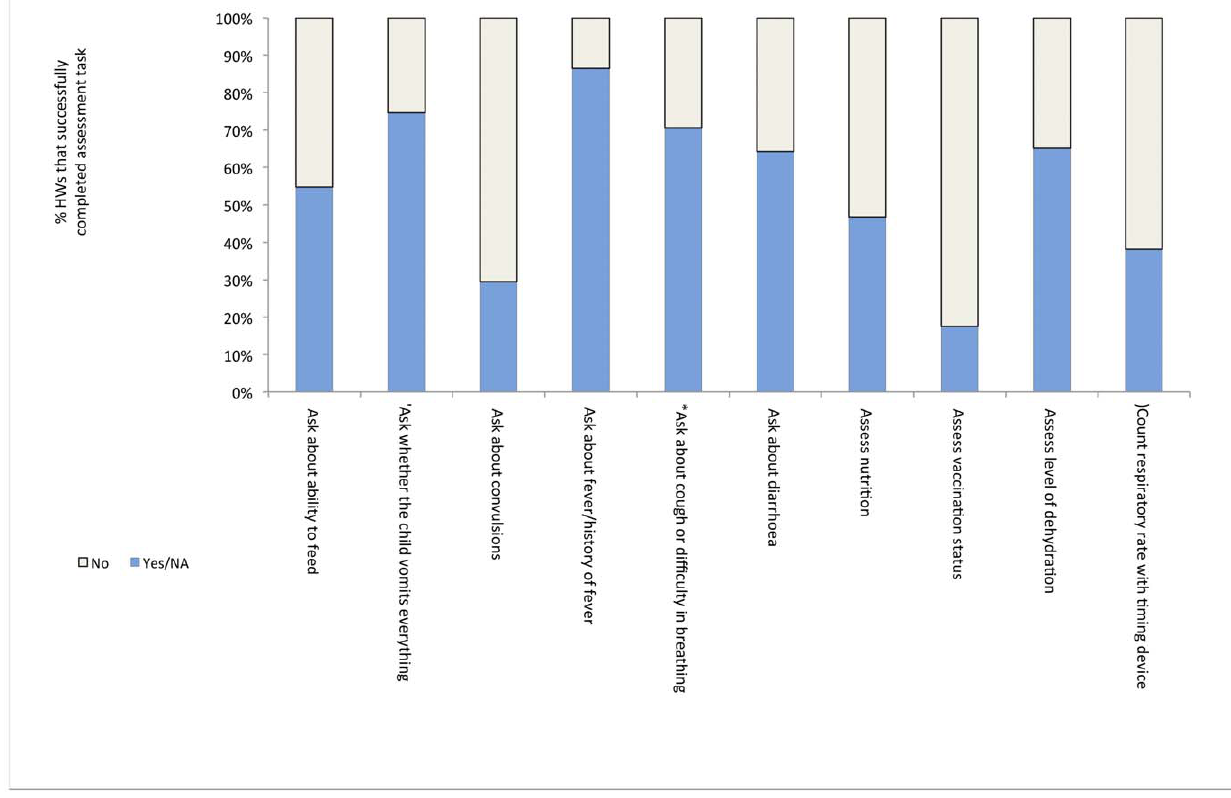
Table S1 Prioritization of Problem Areas to Address.